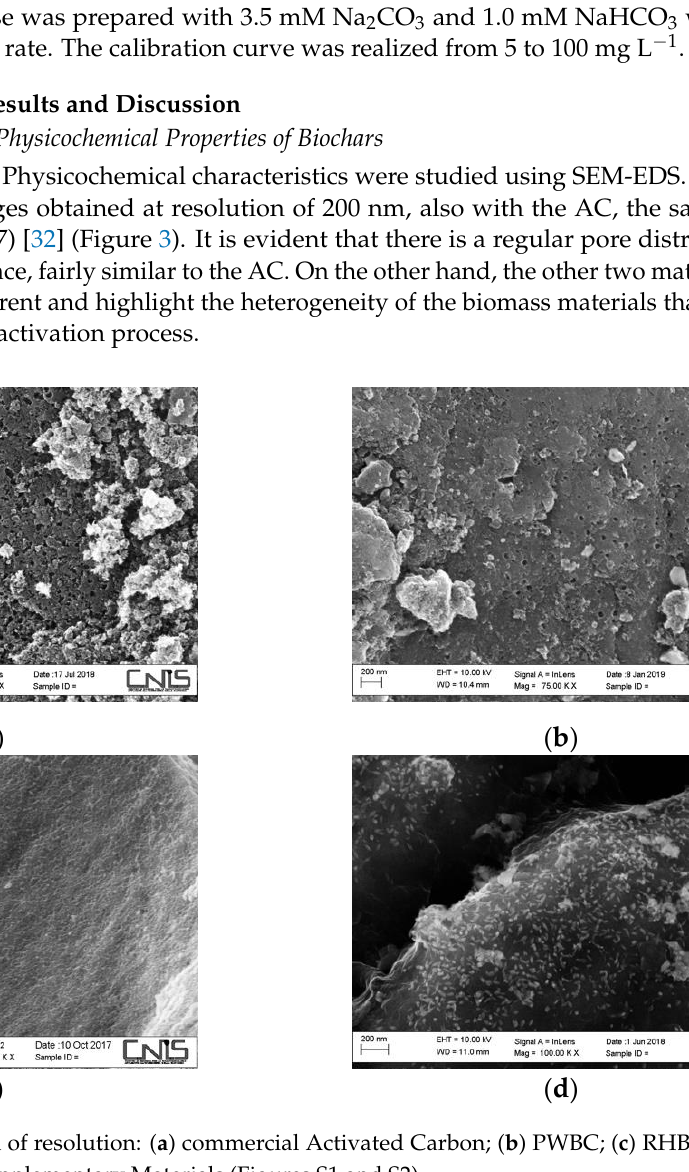
Table 1. Results of textural characterization